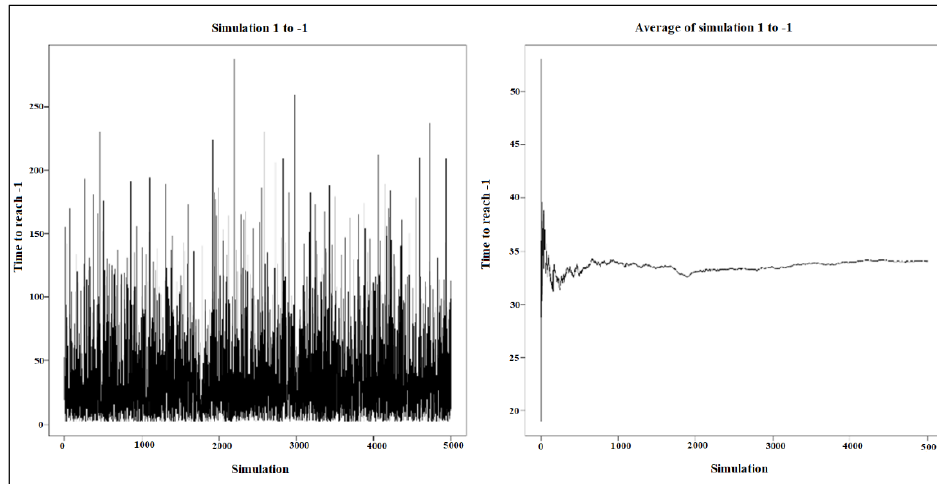
Figure 4. Simulations and average time of state “1”. Source: Own elaboration with R-project.